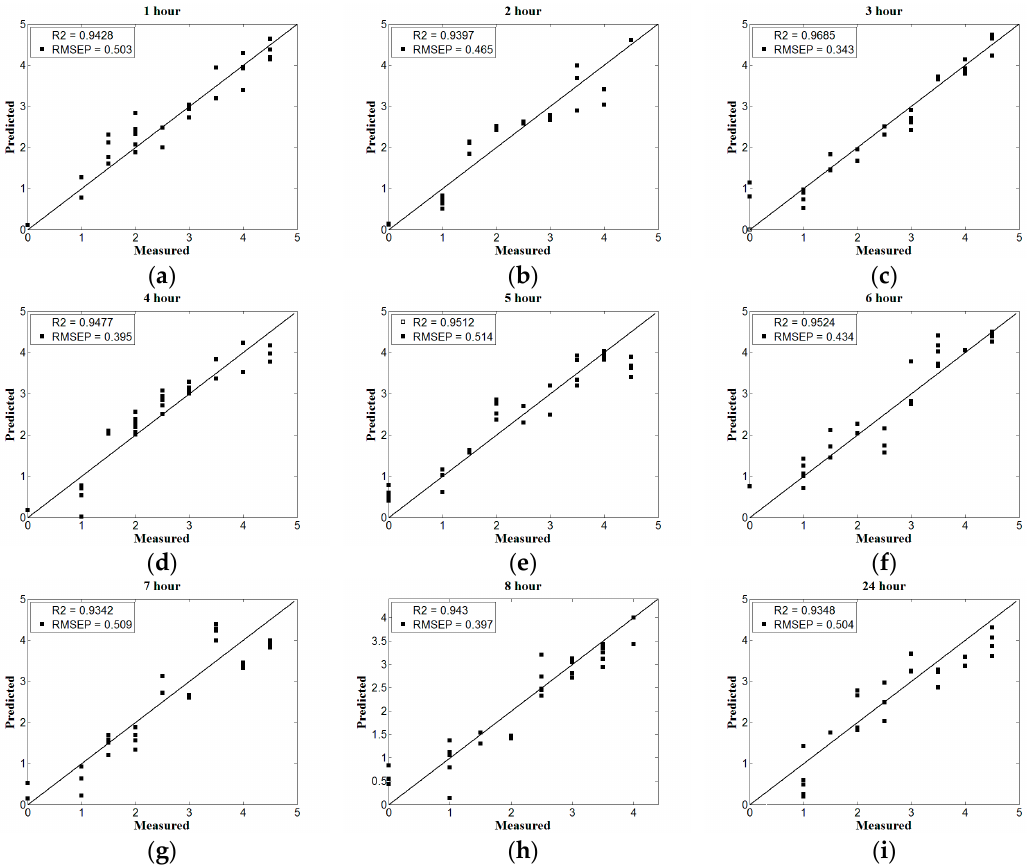
Figure 4. The UVE model performance under different drying time. ( a – i ) represent the drying time from 1 h to 8 h and 24 h respectively.